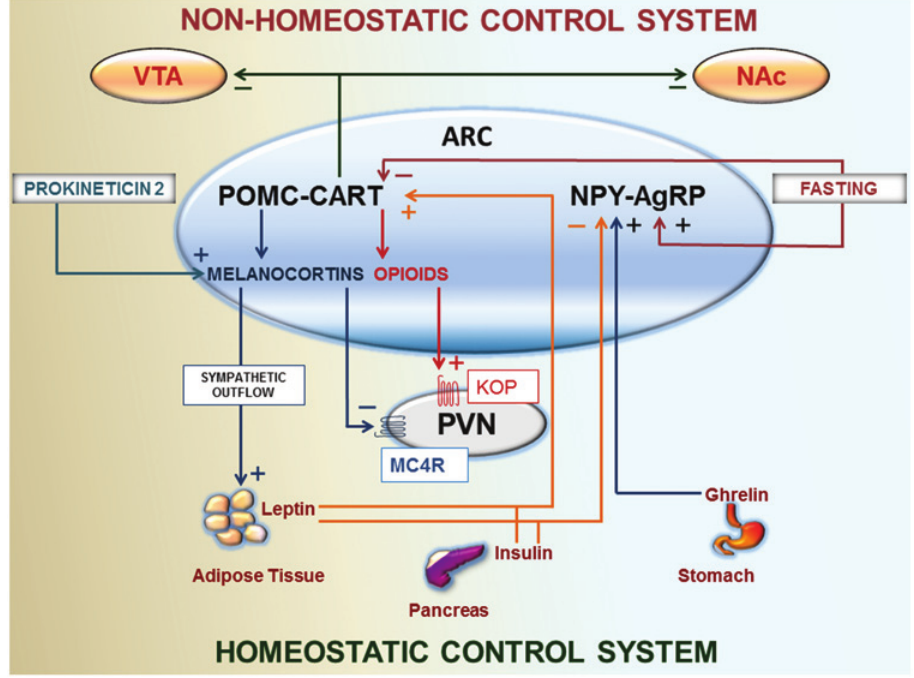
Figure 1: Place of melanocortins in the peptidergic regulation of food intake (either ‘homeostatic’, ‘energy balance-regulated’, or ‘non-homeostatic’, ‘hedonic’ eating) and energy expenditure and their relationships with other neuropeptides involved in body weight